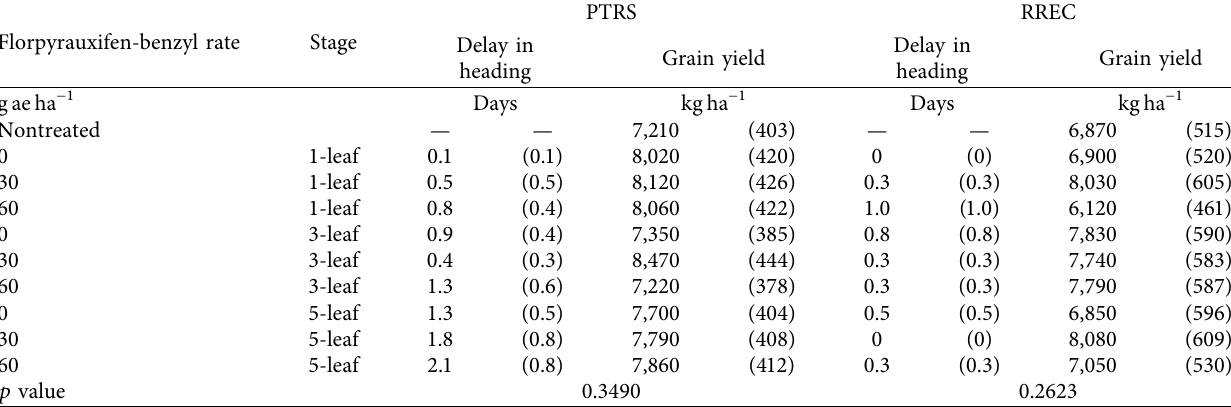
Table 5: Heading and grain yield response of CL272 at the Pine Tree Research Station (PTRS) and Rice Research and Extension Center (RREC) a,b,c .